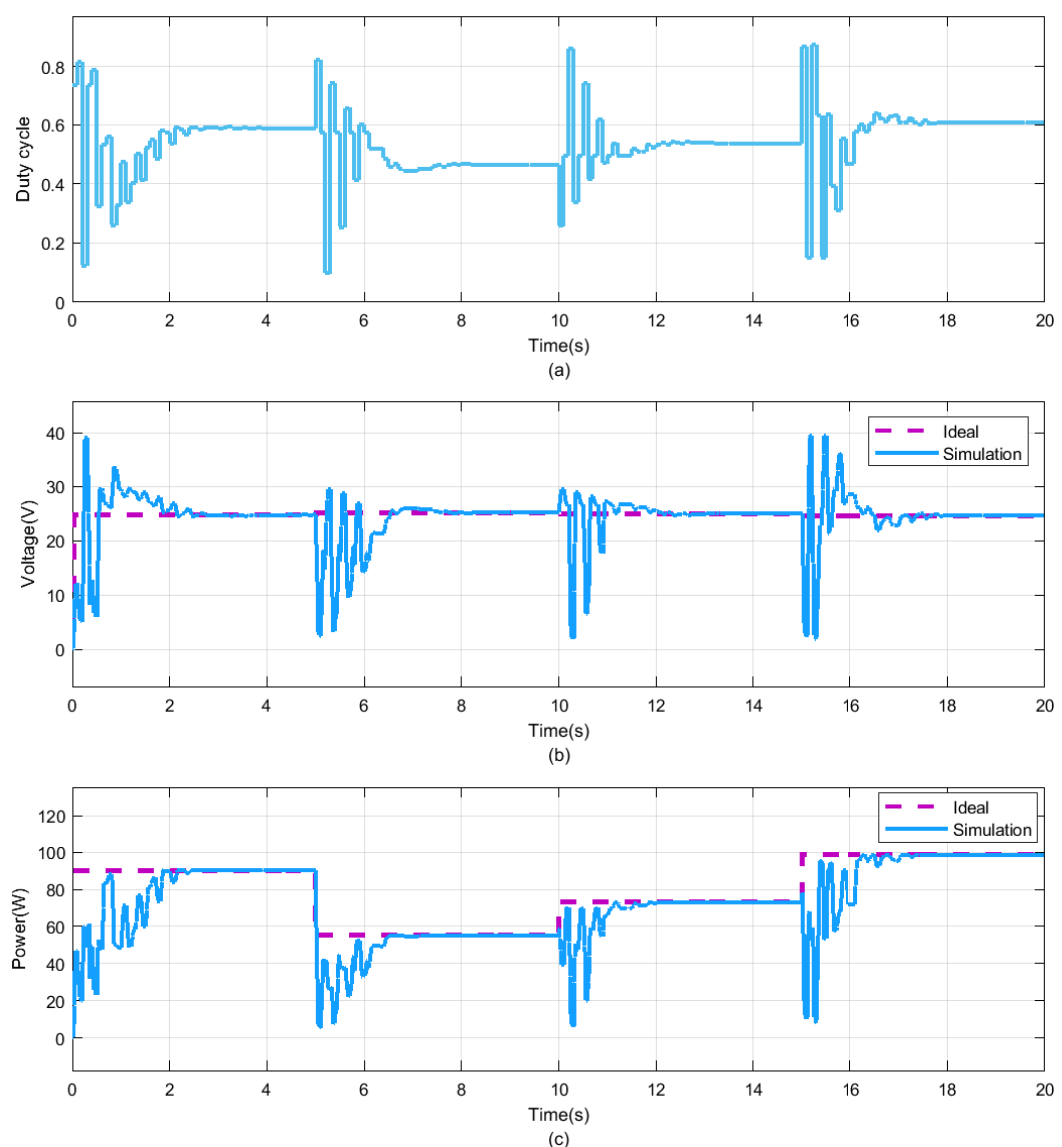
Figure 17. Simulation results under different sets of partially shading and Np = 3 given by Improved Particle Swarm Optimization (IPSO) algorithm: ( a ) Duty cycle, ( b ) Voltage, and ( c )